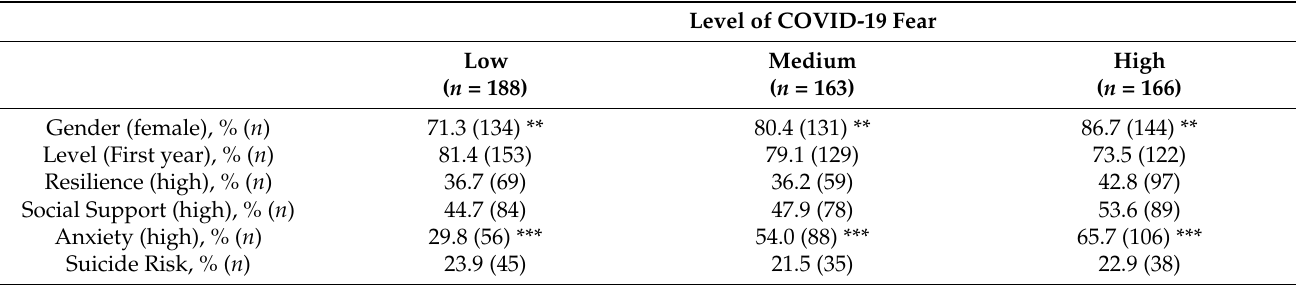
Table 2. Distribution of COVID-19 fear level responses of